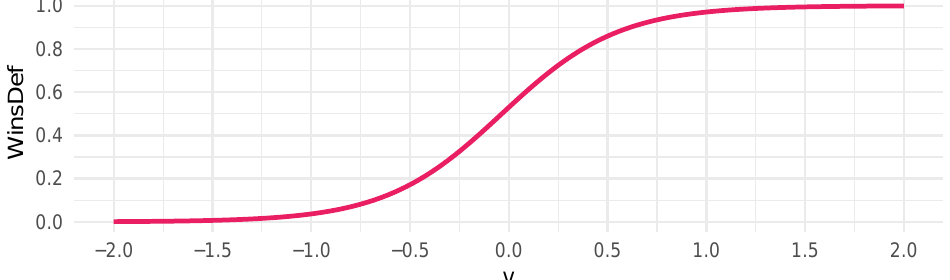
Figure 4. Relationship between v and the probability of being rejected by the defender. Empirical evidence shows that the advantage factor favoring the defender has an important influence in determining which side wins, according to Helmbold’s work